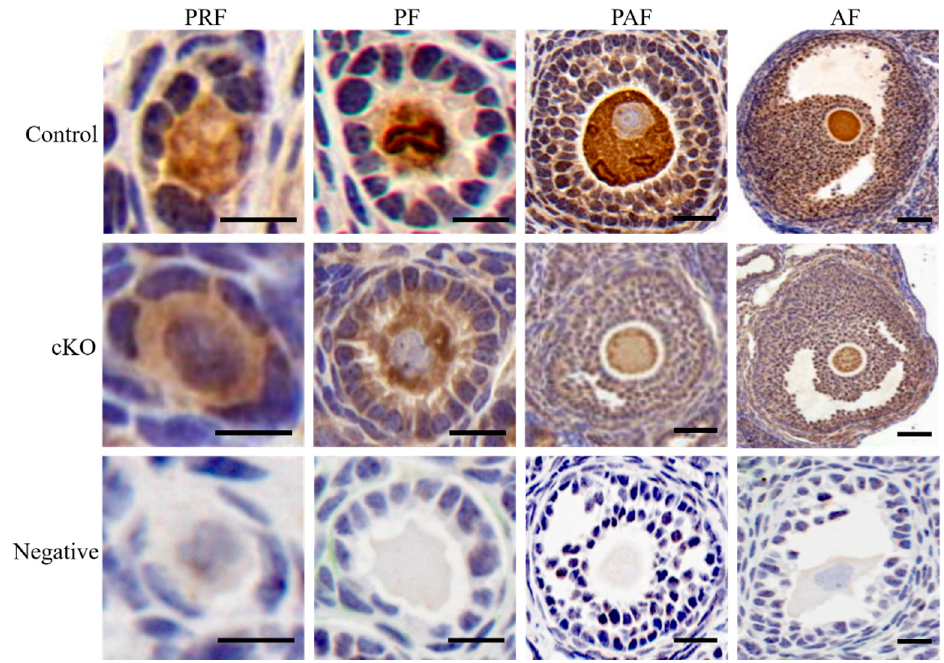
Figure 2. The expression of Kdm2a in growing follicles. Immunohistochemical (IHC) analysis showed the levels of Kdm2a in primordial follicles (PRF), primary follicles (PF), preantral follicles (PAF), and antral follicles (AF). Ovaries from 6-week-old control ( Kdm2a flox/flox ) and Kdm2a cKO (cKO) mice were stained with anti- Kdm2a and then counterstained with haematoxylin. Scale bars, 70 μ m.